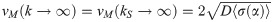
The bet-hedging region is expanded for range expansions in spatially varying environments compared to temporally varying environments.A) Optimal strategy α* as a function of the parameters for spatially varying environments in the limit ks → 0, Eq (9). White lines mark the limits of the bet-hedging region. The limit for which the strategy α = 1 is optimal in temporally fluctuating environments for k → 0 is also shown (gray line) for comparison. B) The velocity obtained by numerical integration of Eq (5) for sa = 0.25, ss = 1, sb = 2 (corresponding to the blue dot of panel A) and different values of kS shown in the figure legend. Light and dark gray lines correspond to the analytical limits for temporally varying environments, vM(k → 0) = (va(α) + vb(α))/2, and vM(k→∞)=vM(kS→∞)=2D〈σ(α)〉, respectively. The red curve is the analytical solution for a spatially fluctuating environment with kS → 0, see Eq (9). Note that in this case, the asymptotic mean velocity does not increase monotonically with kS but is maximal at kS ≈ 0.1.